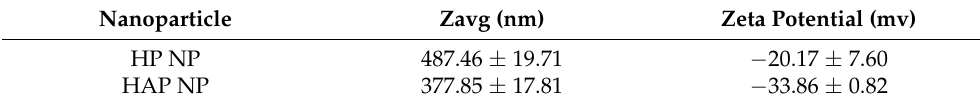
Figure 1. ( A ) Schematic of the heparin/arginine/plasmin (HAP) nanocomplex formation. Heparin was first reacted with plasmin and subsequently complexed with polyarginine. ( B ) (i) Transmission electron microscopy images of the nanoparticles showing the morphology and size range of the nanoparticles with and without plasmin. Scale bar 200 nm. (ii) Size and zeta potential characterization of the plasmin formulation. Dynamic light scattering and zeta measurements revealed sizes around 370–470 nm of the heparin-arginine complex with and without plasmin. Table 1. Nanoparticle size and zeta potential.